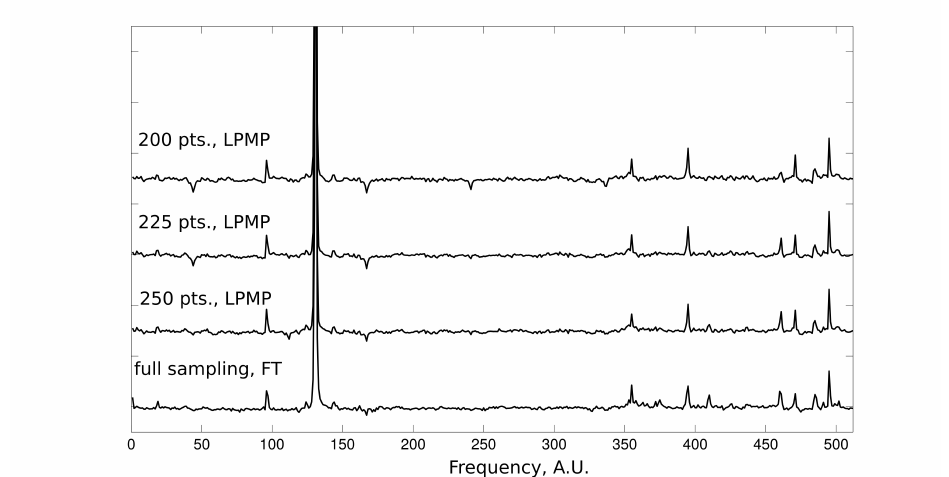
Figure 3. 1D indirect dimension slice from 2D NOESY spectrum: LPMP-reconstruction from 200, 225 and 250 samples out of a 512-point full grid compared with a fully sampled